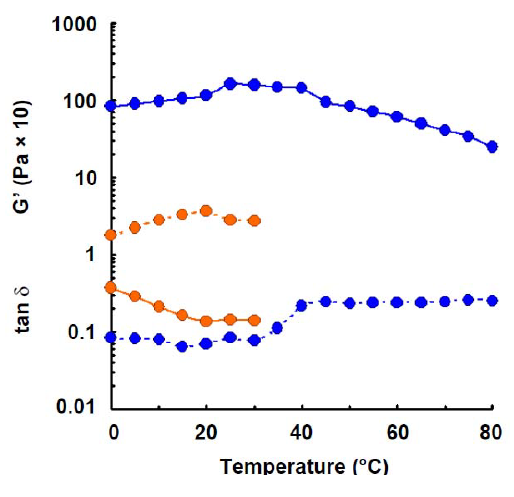
Figure 5. Effect of temperature on the elastic modulus and tan δ of wheat amylose (1.6%) in alkaline solution (0.05 M NaOH). Symbols: preparation in distilled water, ●; preparation in 0.05 M NaOH, ●. Lines: storage modulus, solid; tan δ, dotted.